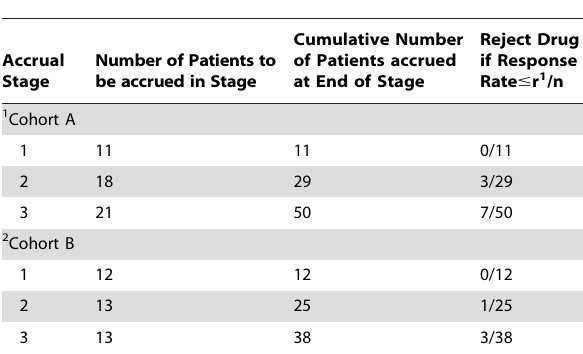
Table 3. Three-stage patient accrual.